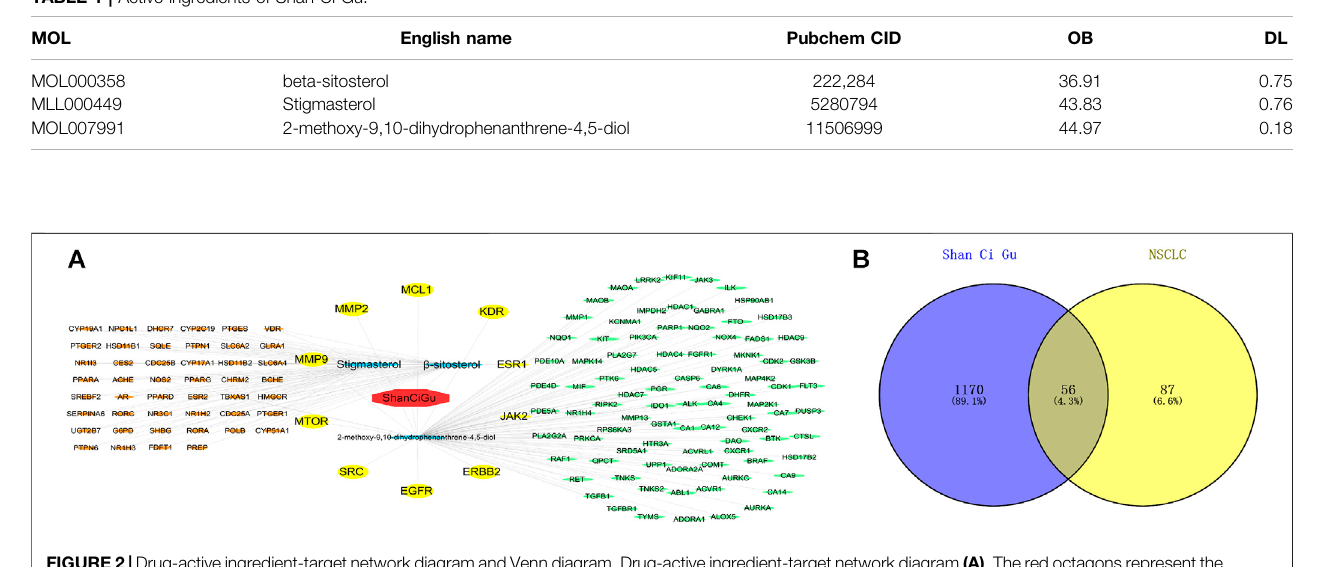
FIGURE2| Drug-activeingredient-targetnetworkdiagramandVenndiagram. Drug-activeingredient-targetnetworkdiagram (A) .Thered octagonsrepresentthe drug,theblueovalsrepresenttheactiveingredientsofthedrug.Theyellowovalsrepresentthehubgenes,theorangeovalsrepresenttherelevanttargetsofstigmasterol and β -sitosterol,and thegreenovalsrepresenttherelevanttargets of2-methoxy-9,10-dihydrophenanthrene-4,5-diol. Linesrepresenttherelationshipsbetweennodes; the more connections the nodes have, the more important they are. Venn diagram (B) . The blue part represents the number of drug targets, and the yellow part represents the number of disease